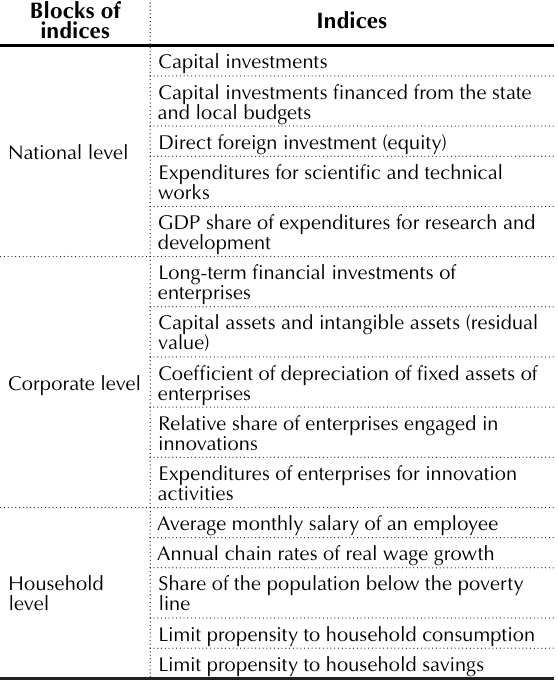
Table 2. System of investment and